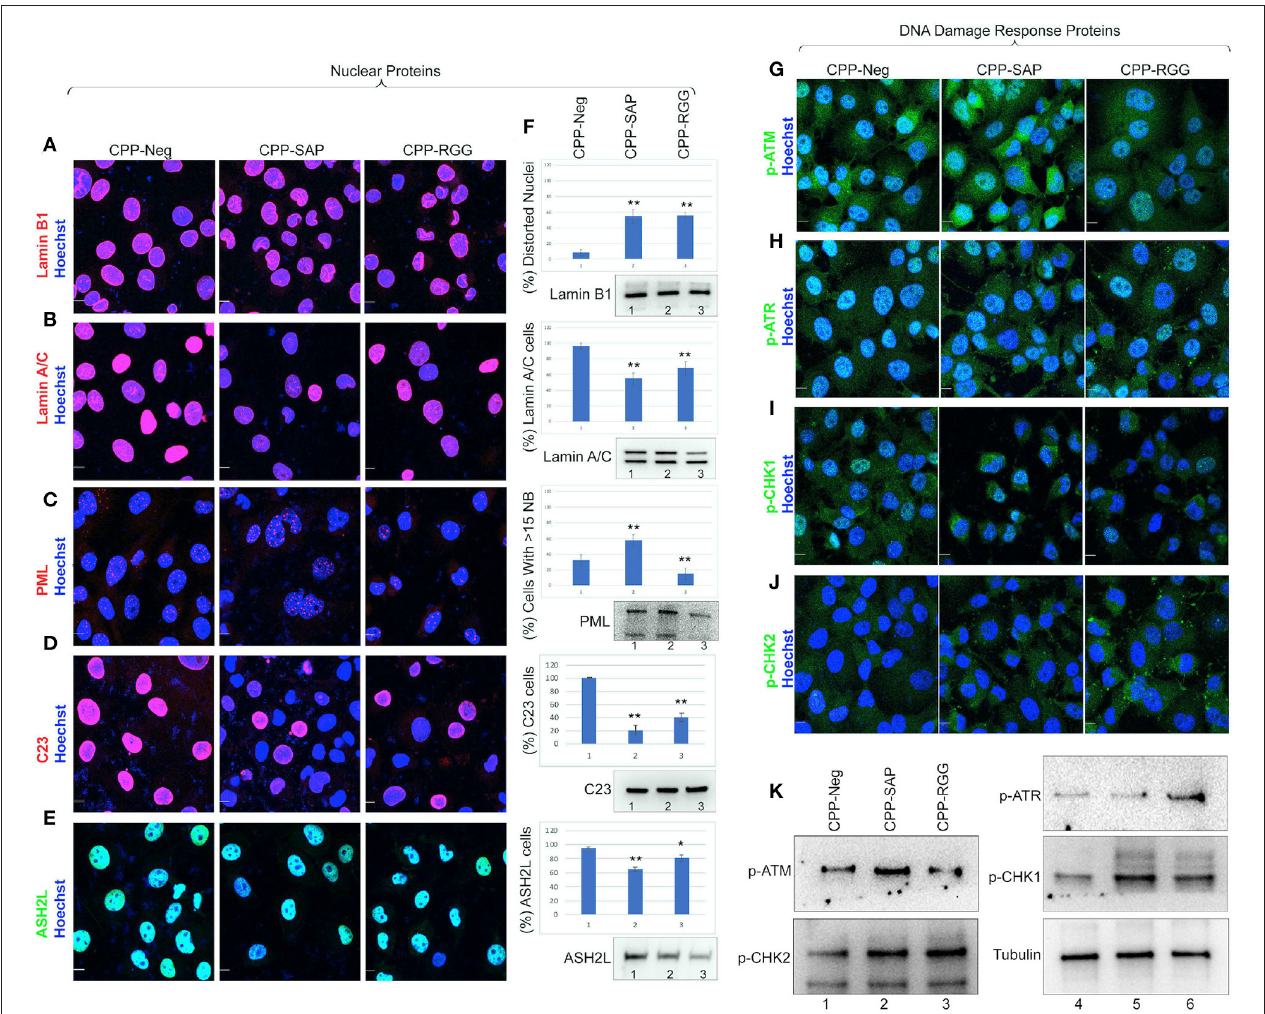
FIGURE 6 | CPP-RGG and CPP-SAP disrupt nuclear architecture and nuclear protein levels and activate DDR pathways in HCT116 cells. (A–E) Representative immunofluorescence images for lamin B1, lamin A/C, PML, C23 (red); ASH2L (green); nuclei (Hoechst, blue) after 24h of treatment. Scale bar, 10 µ m. (F) Quantitation of cells for protein or nuclear feature. Immunoblots showing the endogenous protein levels. (G–J) Immunofluorescence for DDR effectors (green) and nuclei (Hoechst, blue) in CPP-treated HCT116 cells. Scale bar, 10 µ m. (K) Immunoblots of p-ATM, p-ATR, p-CHK1, p-CHK2, and tubulin levels in HCT116 cells treated with SAFA-derived peptides. * p < 0.05, ** p < 0.01 relative to